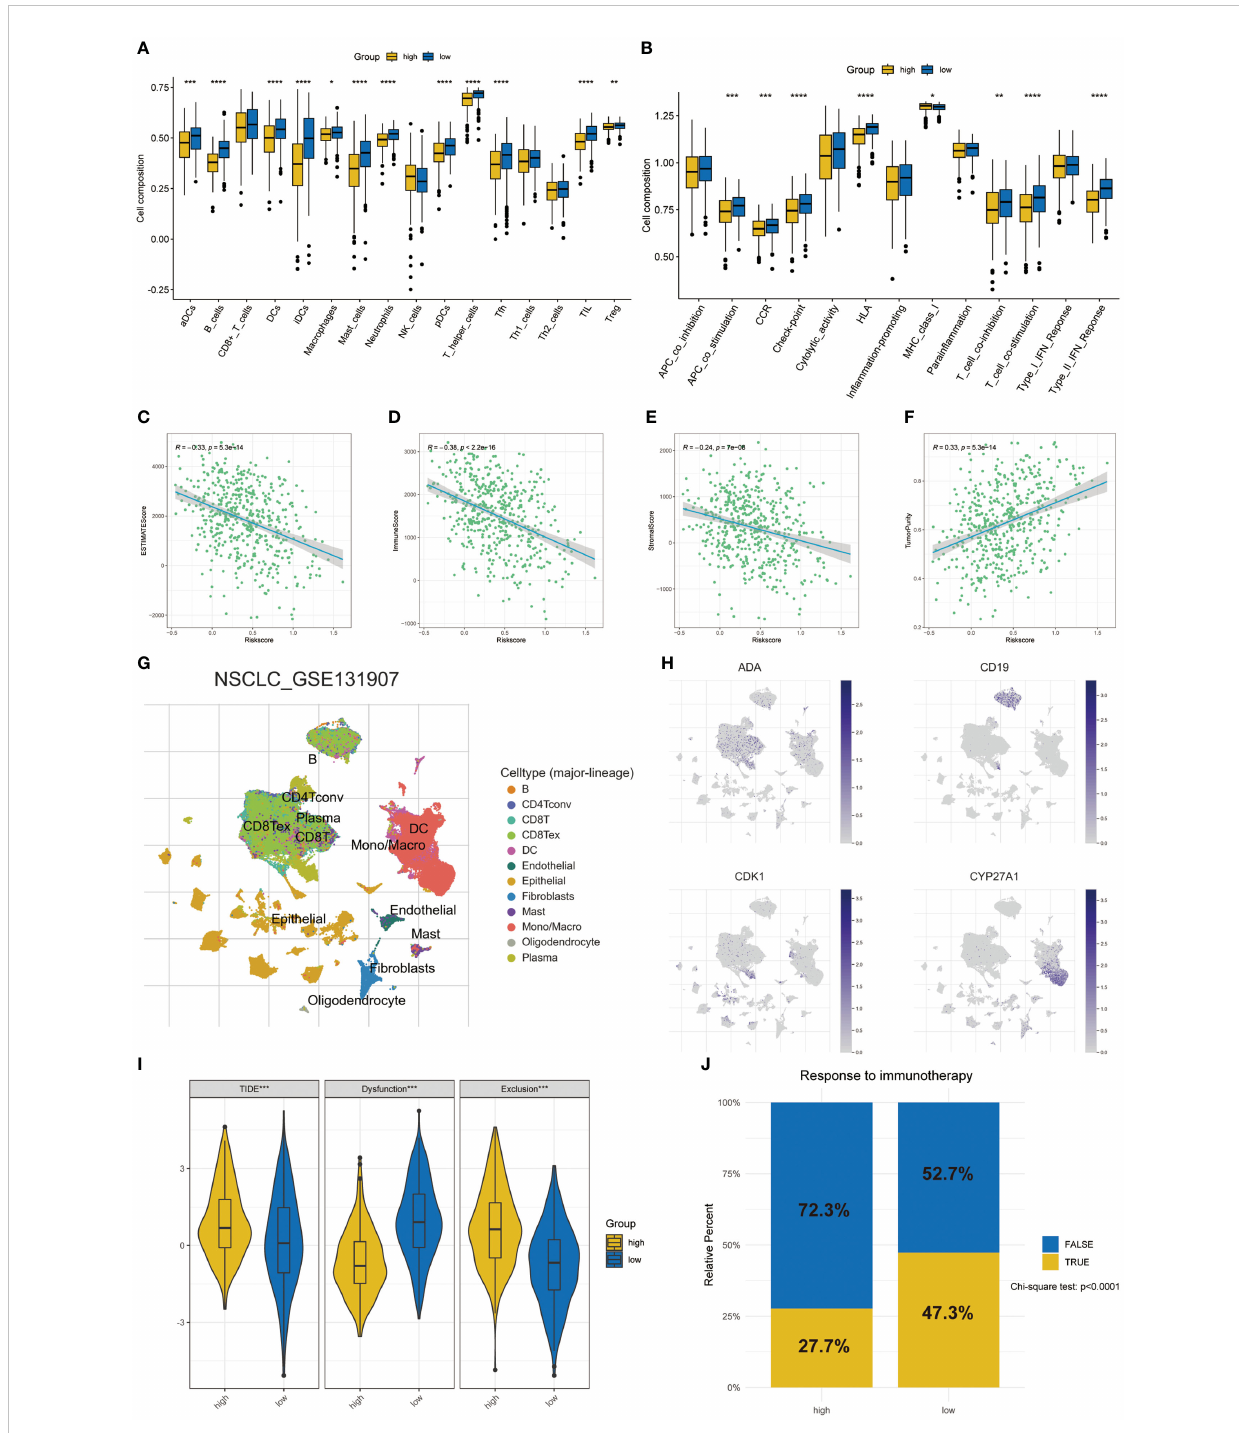
FIGURE 6 Differences of TME in two risk groups. (A) The differences in the proportions of 16 immune cells. (B) The differences of 13 immune-related pathways. Correlation between risk score and ESTIMATE score (C) , immune score (D) , stromal score (E) , and tumor purity (F) in two groups. (G) The annotation of celltypes in GSE131907. (H) The expression of key T cell proliferation regulators in GSE131907. (I) The differences of TIDE score. (J) Response to immunotherapy based on the TIDE algorithm. *p < 0.05, **p < 0.01, ***p < 0.001, ****p <